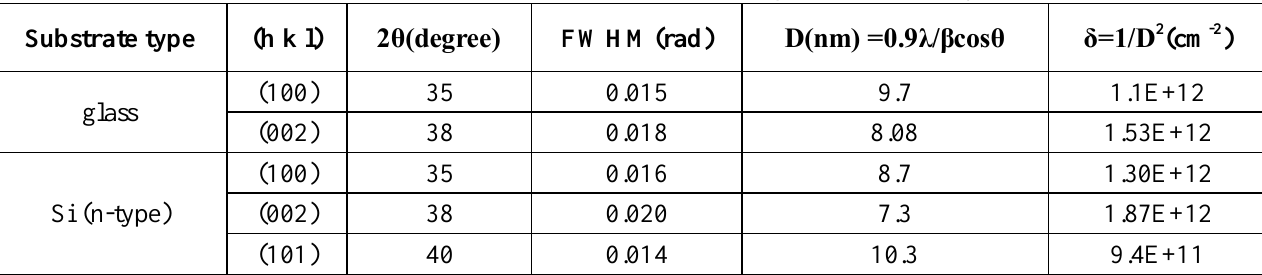
Figure 6: Reflectance spectra of Ti nanoparticles on Si (n-type) substrate at 5 min & 10 min. Table 1. XRD parameter of Ti thin films on glass and Si